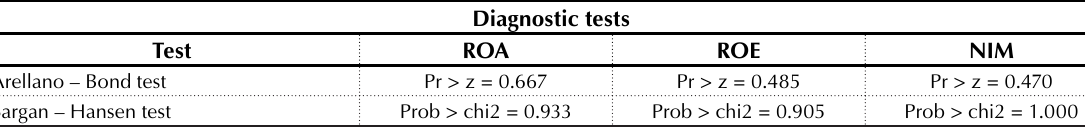
Table 3. The diagnostic